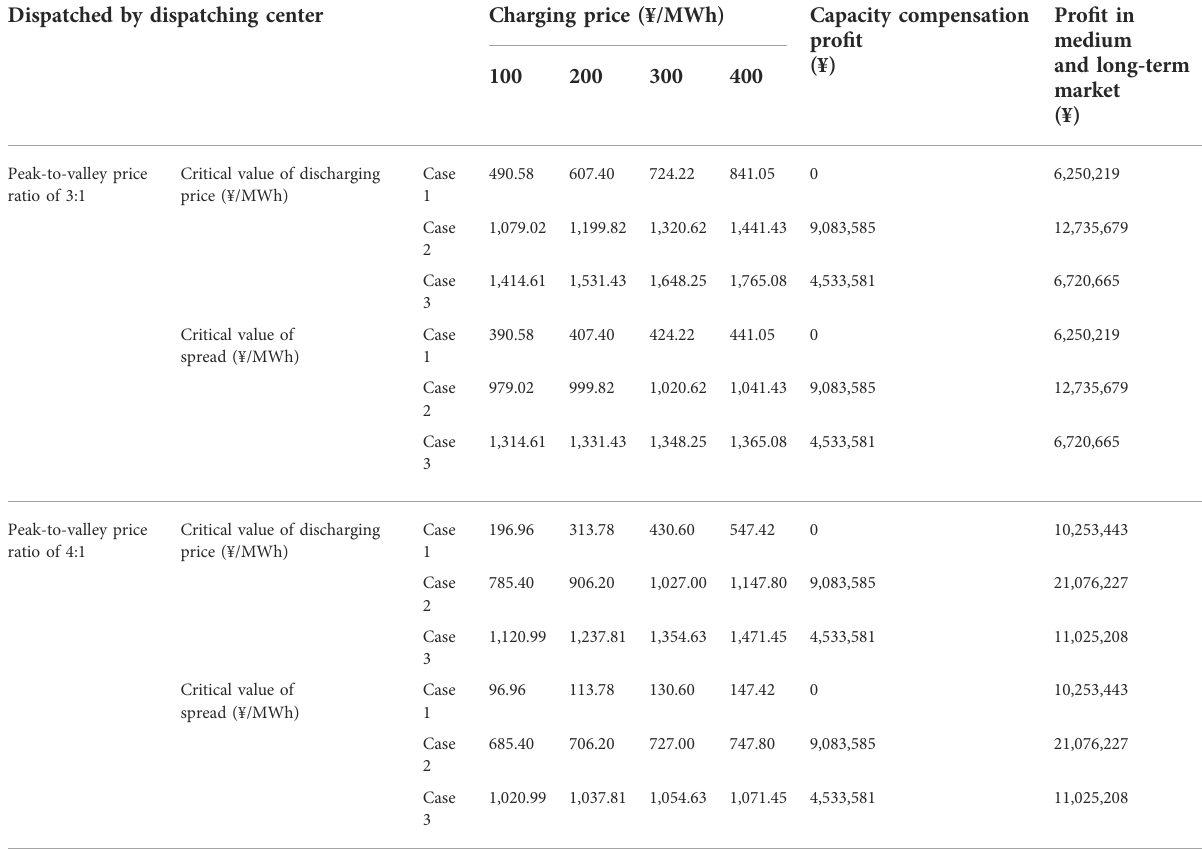
TABLE 6 Critical values of discharging price and charging-discharging